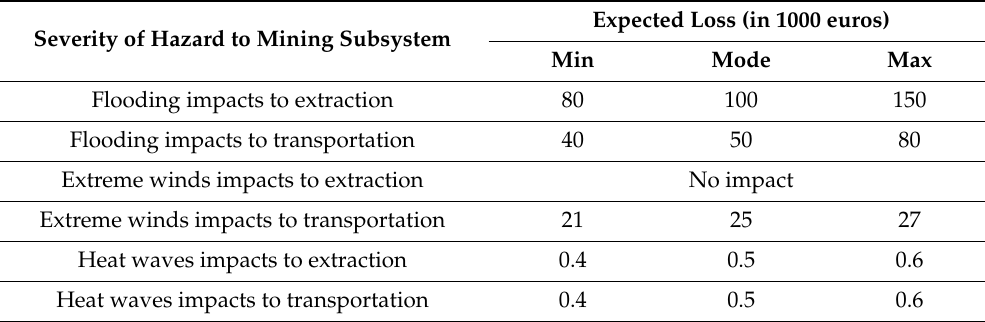
Table 7. Expected economic losses for CLIRMI mine (per